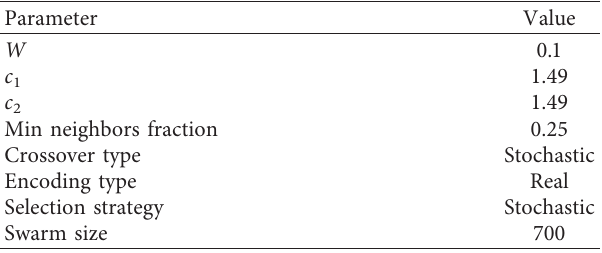
Table 2: The configuration of the PSO algorithm